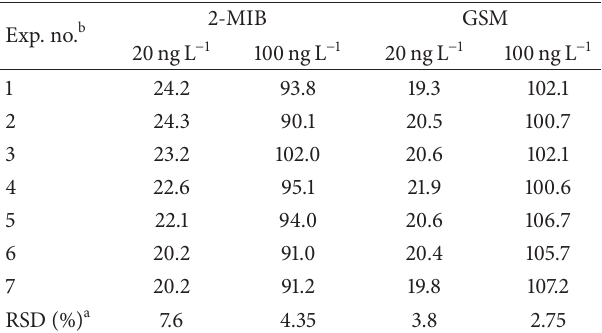
Table 8: The relative standard deviations (RSDs) a for 2-MIB and